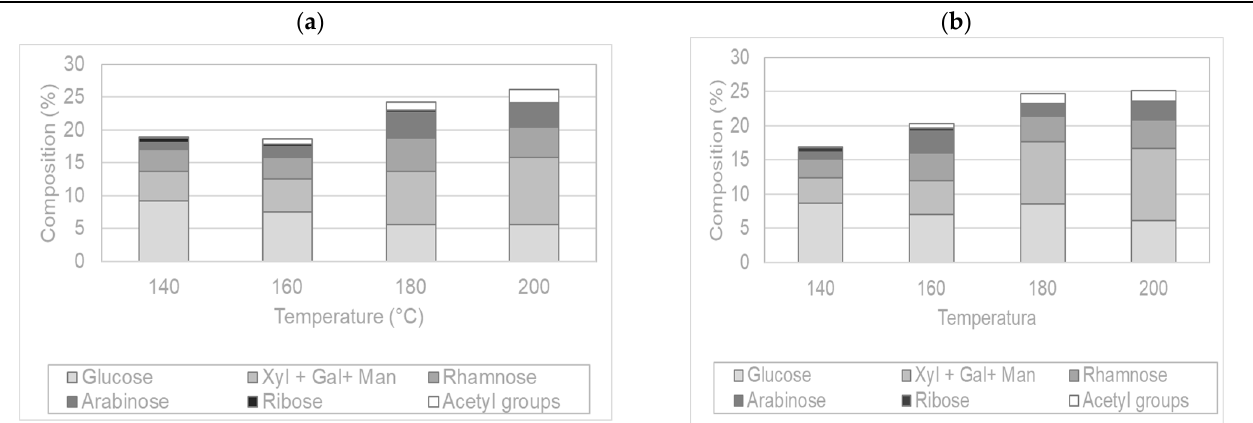
Figure 5. Soluble oligomers and other groups found in the extracts obtained with ( a ) PHWE-MH and ( b ) PHWE-CH at different temperatures.